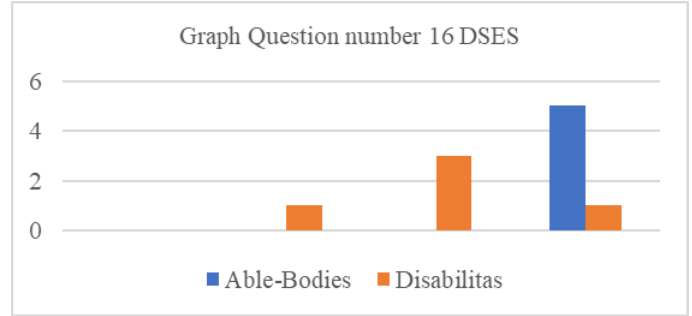
Figure 2. Distribution of respondents'